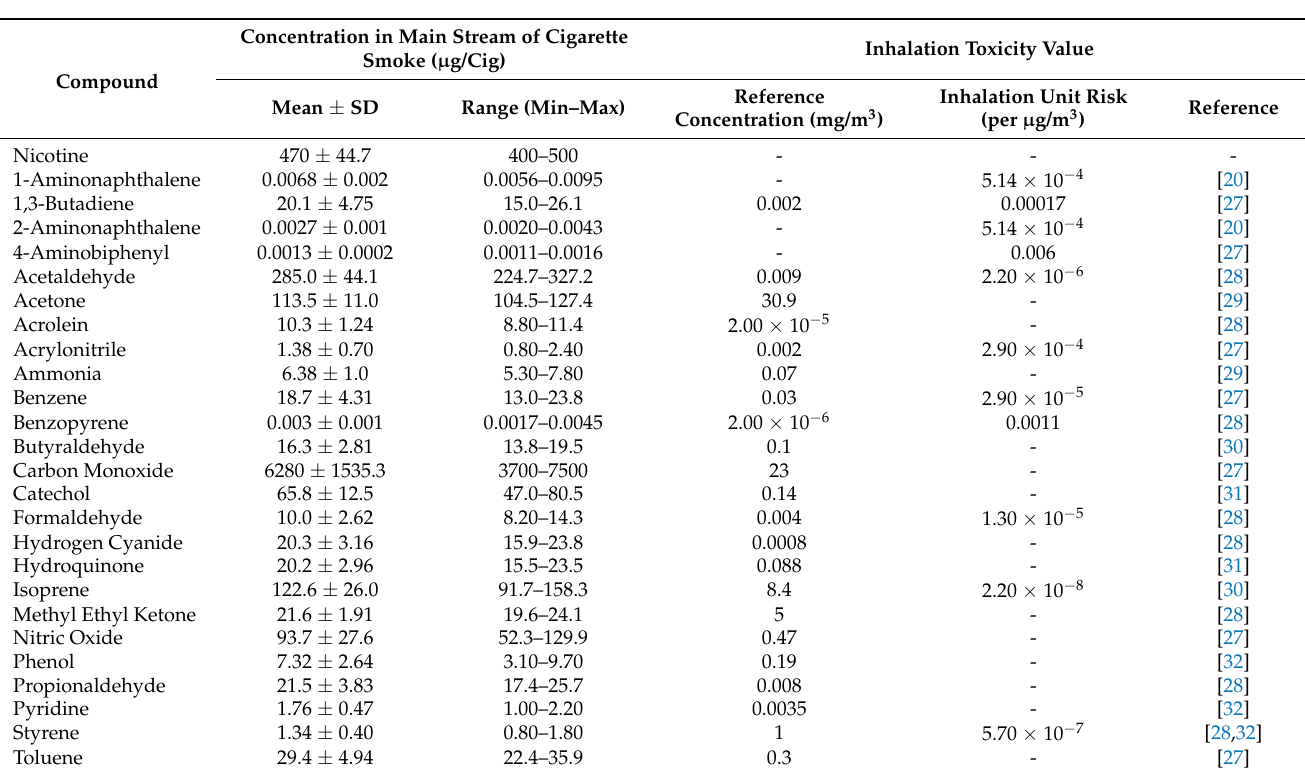
Table 3. The concentration of the selected toxic compounds in cigarette smoke composition and their inhalation toxicity